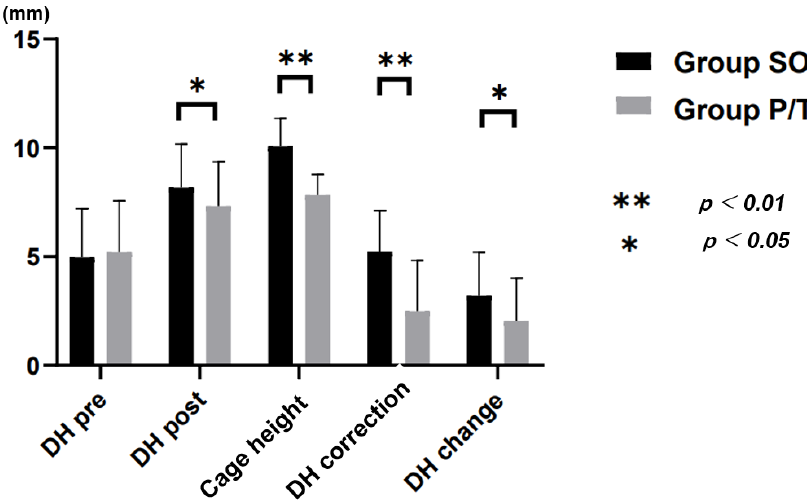
Figure 5. Radiological result. DH: disc height; CDR: cage disc ratio.